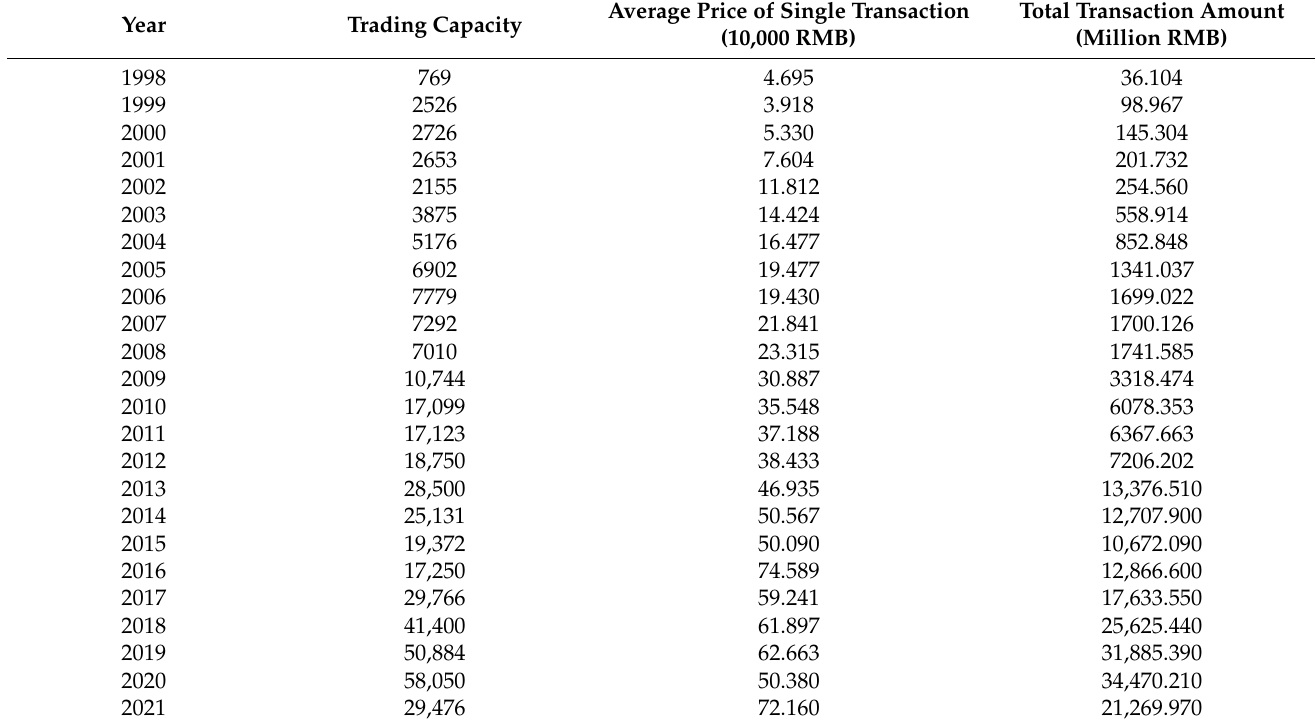
Table 1. Housing sample